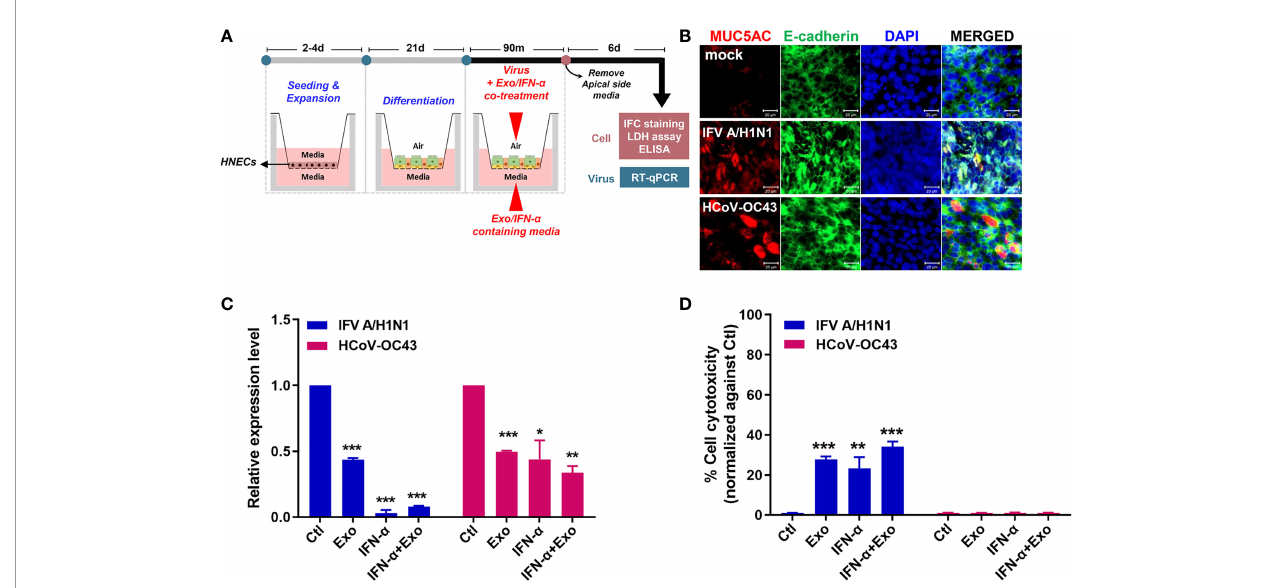
FIGURE 6 | U-exo treatment in human nasal epithelial cells (HNECs) cultured at the air-liquid interface (ALI) exhibits an antiviral effect. (A) A schematic representing the experimental design. The differentiation status of the HNECs cultured at the ALI was con fi rmed prior to their infection with IFV A/H1N1, or HCoV-OC43. The infected cells of the ALI culture model were subject to further analysis to determine the antiviral effects of U-exo treatment. (B) HNECs cultured at the ALI were infected with IFV A/H1N1, or HCoV-OC43 viruses (MOI= 10). Structural integrity of the epithelium was evaluated by staining E-cadherin (green) and goblet cells were visualized by MUC5AC (red) staining. Scale bar = 20 m m. (C) Apical side was infected with IFV A/H1N1, or HCoV OC43 viruses (MOI= 10) at the same time as treatment with control (Ctl), U-exo (Exo), IFN- a (10 ng/mL), IFN- a in combination with U-exo (IFN- a +Exo). After 90 min incubation, media was removed from the apical side, and media containing U-exo and/or IFN- a was added to the basolateral side. Viral gene expression levels were determined after 6 days using RT-qPCR. *p < 0.05; **p < 0.01; ***p < 0.001, versus Ctl-treated cells. (D) The supernatants from the basolateral side were harvested to measure the extracellular release of lactate dehydrogenase (LDH) levels. Data are shown as the mean ± standard deviation (SD) of two independent experiments. **p < 0.01; ***p < 0.001, versus Ctl- treated cells.